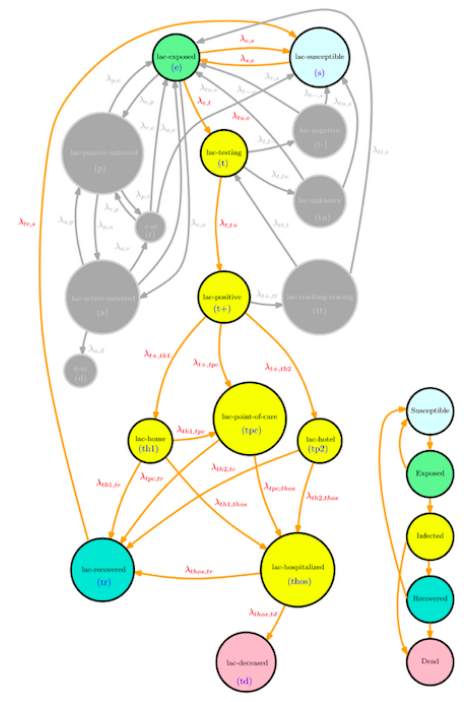
Figure 11. Connection of the dynamics of